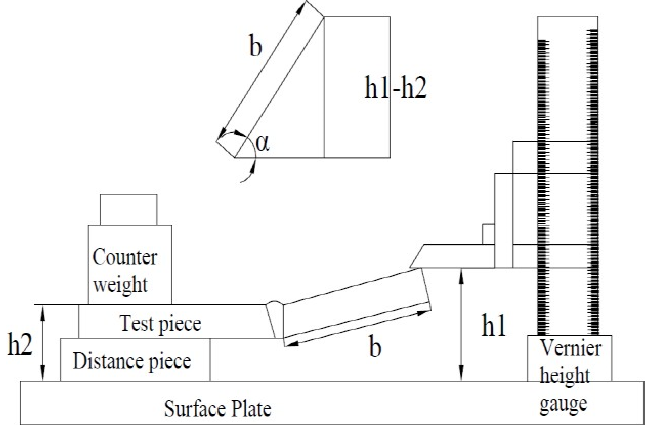
Figure 3. Schematic showing the welded joint disposition for the measurement of the distortion via the Vernier height gauge and definition of the distortion angle α ( ◦ ).